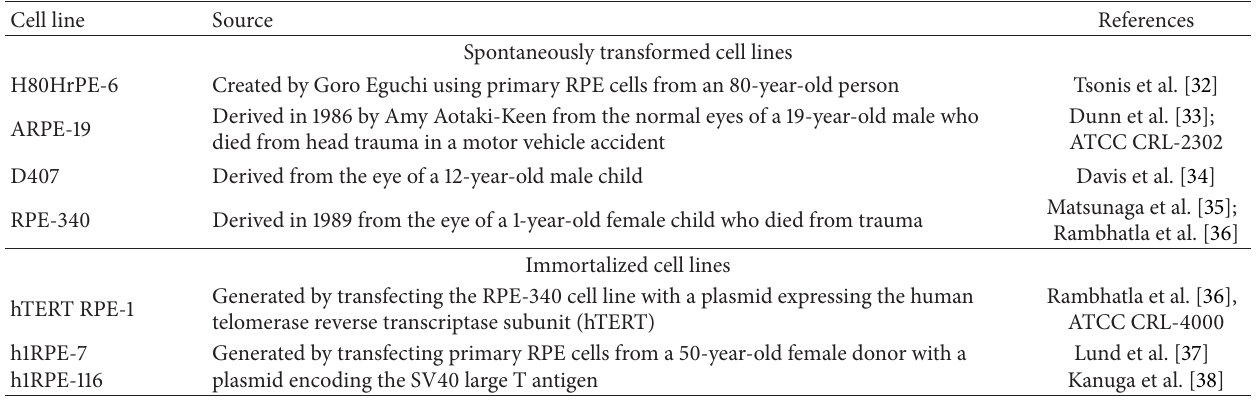
Table 1: Human RPE cell lines (according to Mannermaa [31],